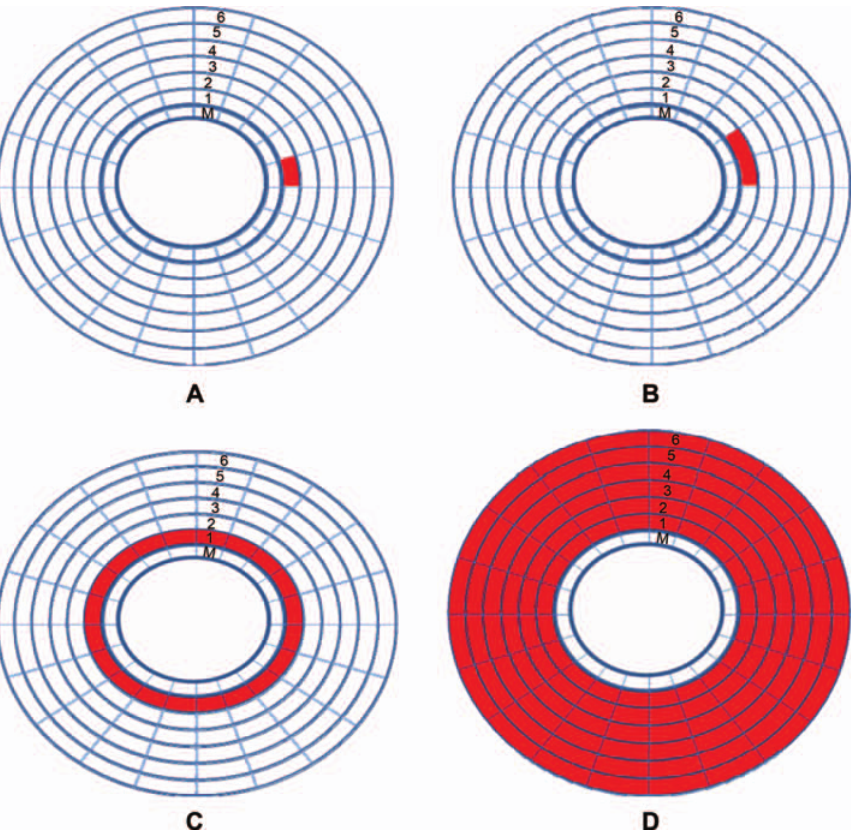
Figure 4 Procedure for the simulation of the heating process. (A) Total fi nite element mesh is generated with one active element, i = 1, j = 1, other composite elements are dead; (B) two active elements, I = 1, j = 2; (C) fi rst layer is deposited, i = 1, j = 20; (D) the whole six layers are depos- ited I = 6, j =